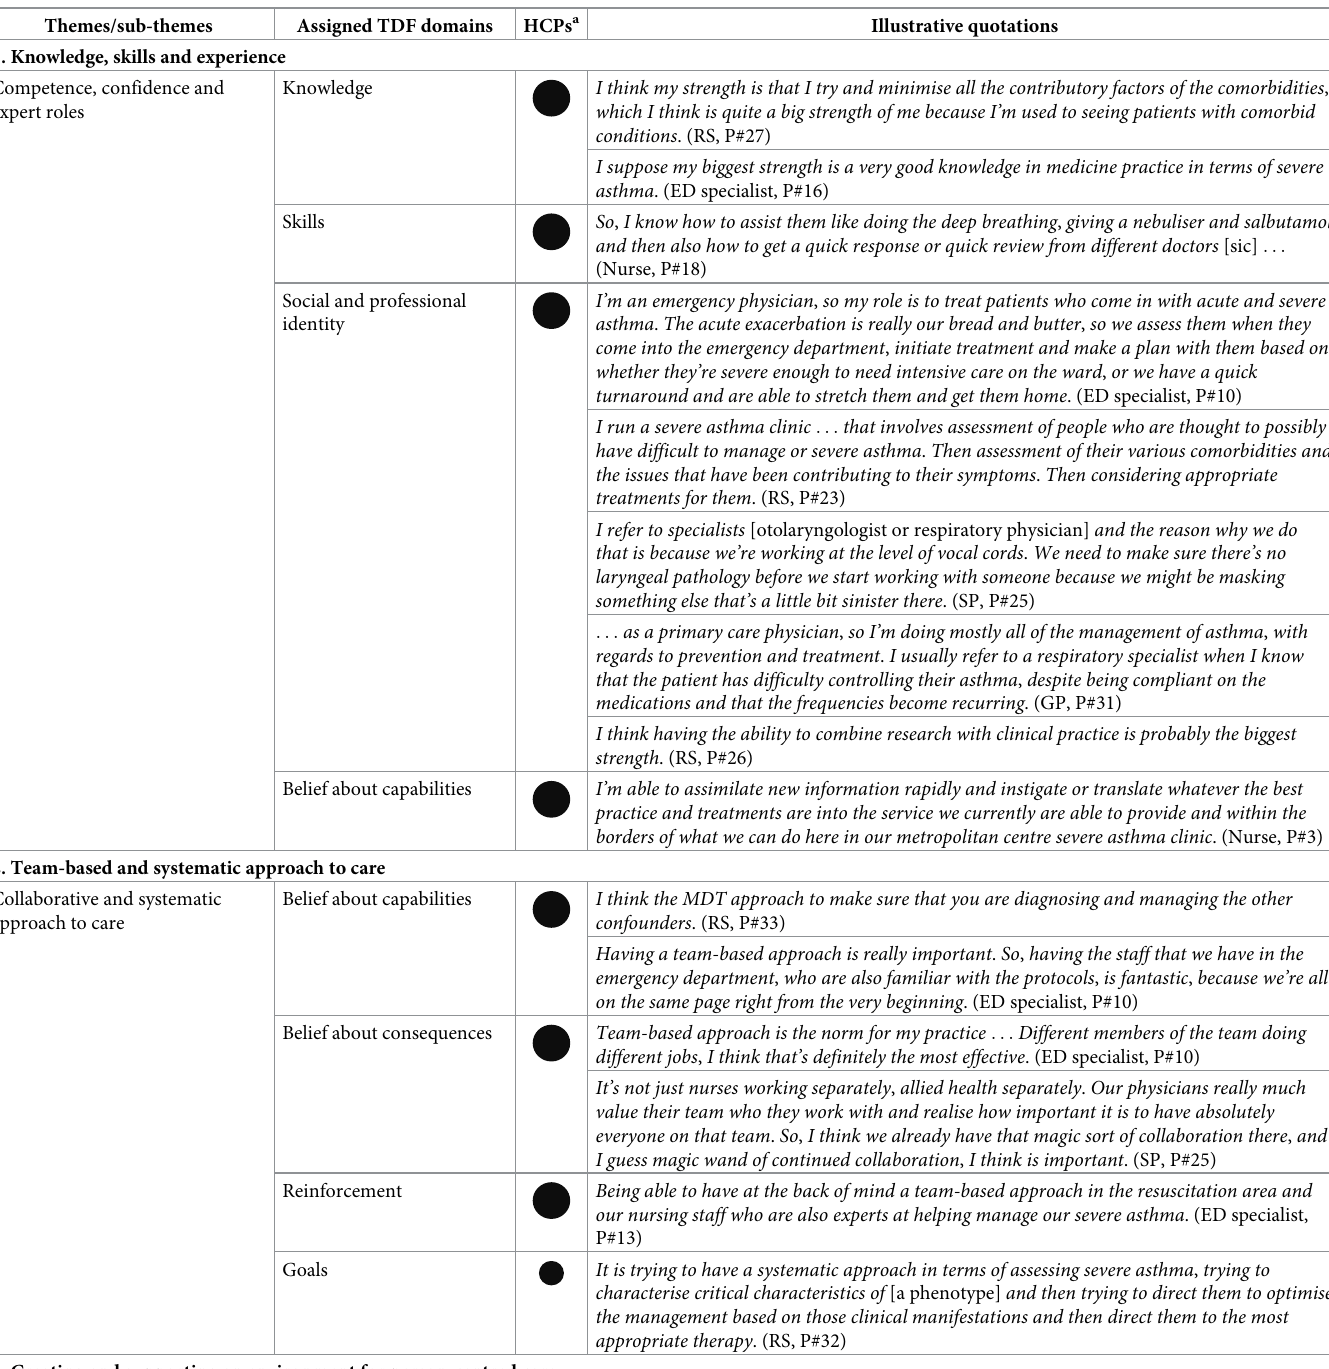
Table 4. Illustrative quotations regarding enablers for optimal